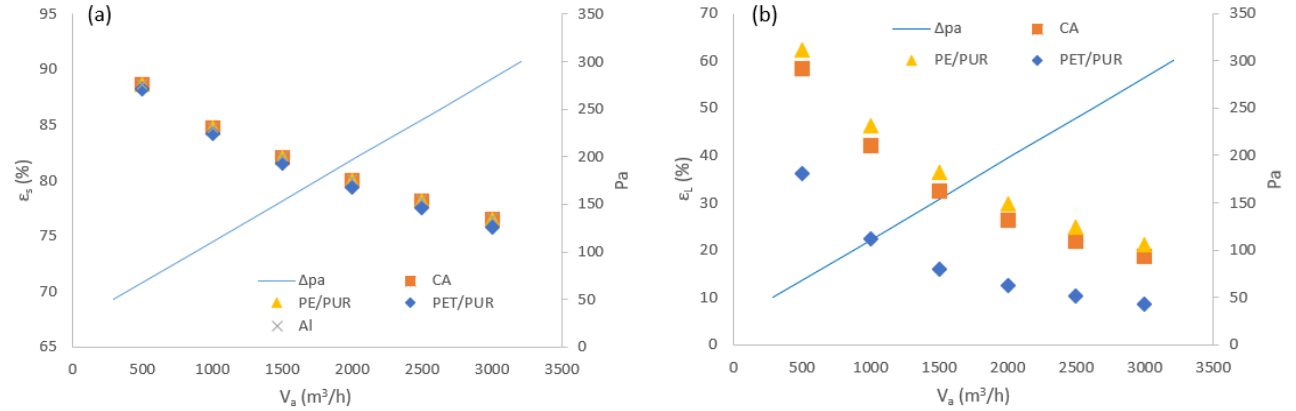
Figure 13. Effectiveness with a variable airflow and a uniform membrane thickness of 100 µm. ( a ) Sensible effectiveness; ( b ) Latent effectiveness.